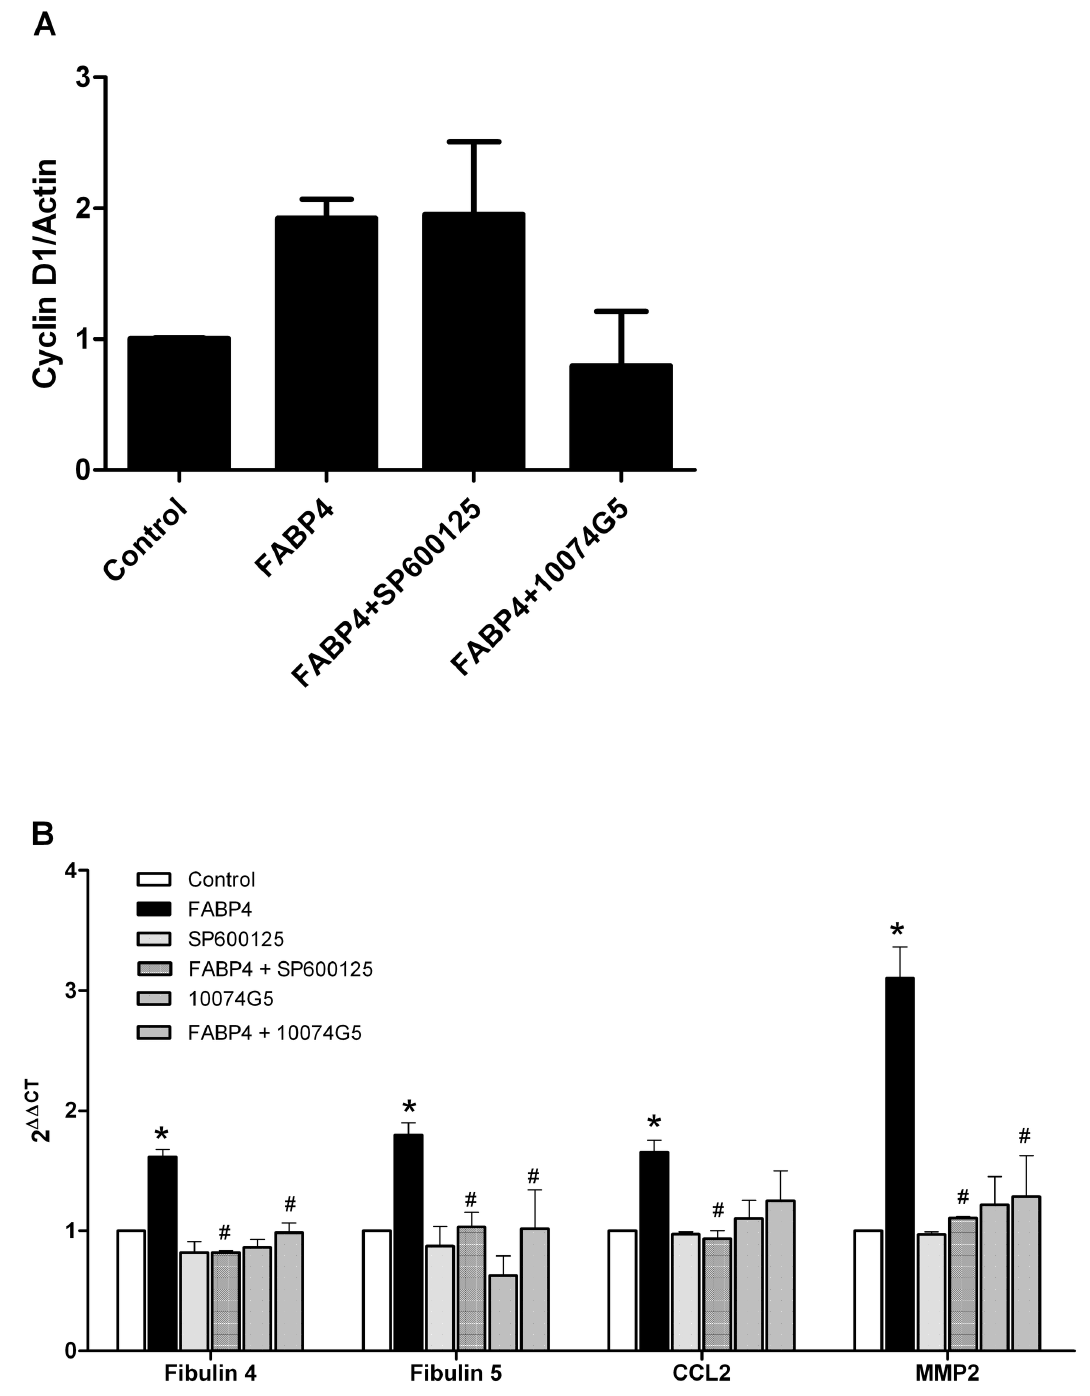
Figure 6. Effect of FABP4 on target genes regulated by c-fos and/or c-myc. (A) Effect of FABP4 on cyclin D1 expression. Proliferating HCASMC were incubated with 120 ng/ml FABP4 in the presence or absence of c-myc (10074G5) and c-jun (SP600125) inhibitors for 6 h. Western blotting was performed to evaluate the expression of cyclin D1 in the cells, with actin as an internal control. (B) Migrating HCASMC were incubated with 120 ng/ml FABP4 in the presence or absence of c-myc (10074G5) and c-jun (SP600125) inhibitors for 24 h. Total RNA was extracted from the cells, and the expression of fibulin 4, fibulin 5, MMP2, and CCL2 was measured by quantitative RT-PCR using TaqMan primers and the 2ΔΔCt method. *p<0.05 vs unstimulated cells; #p<0.05 vs FABP4-stimulated cells. doi: 10.1371/journal.pone.0081914.g006 PLOS ONE |